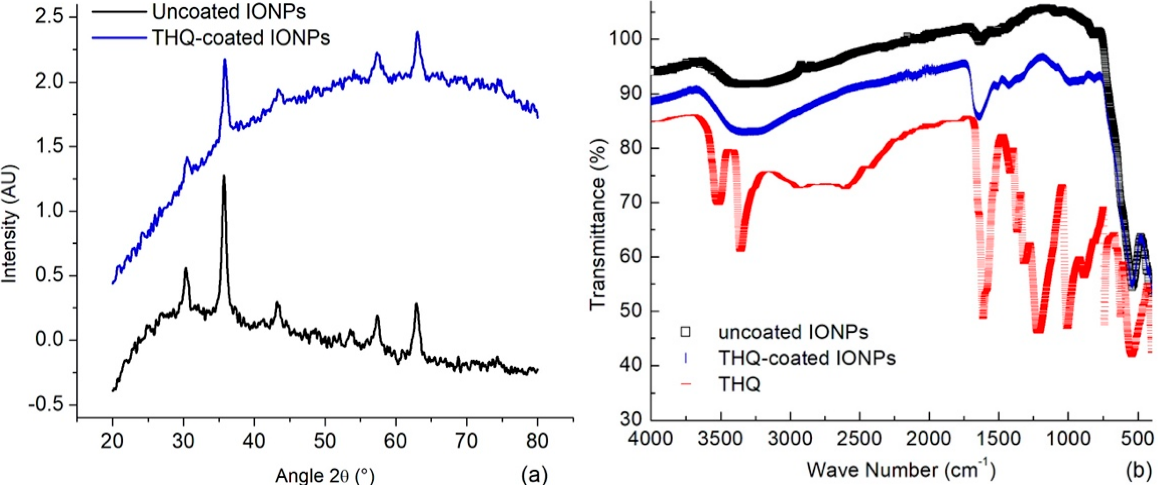
Figure 1. XRD spectra of uncoated (black) and coated IONPs (blue) ( a ) and their FTIR spectra including pure THQ (red) ( b ).